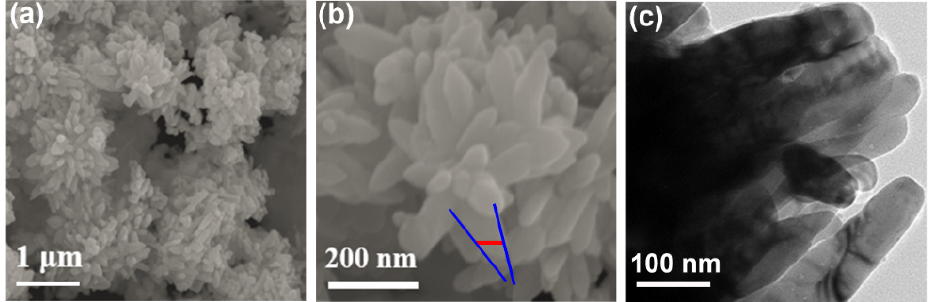
Figure 2. SEM ( a , b ), and TEM ( c ) images of ZnO